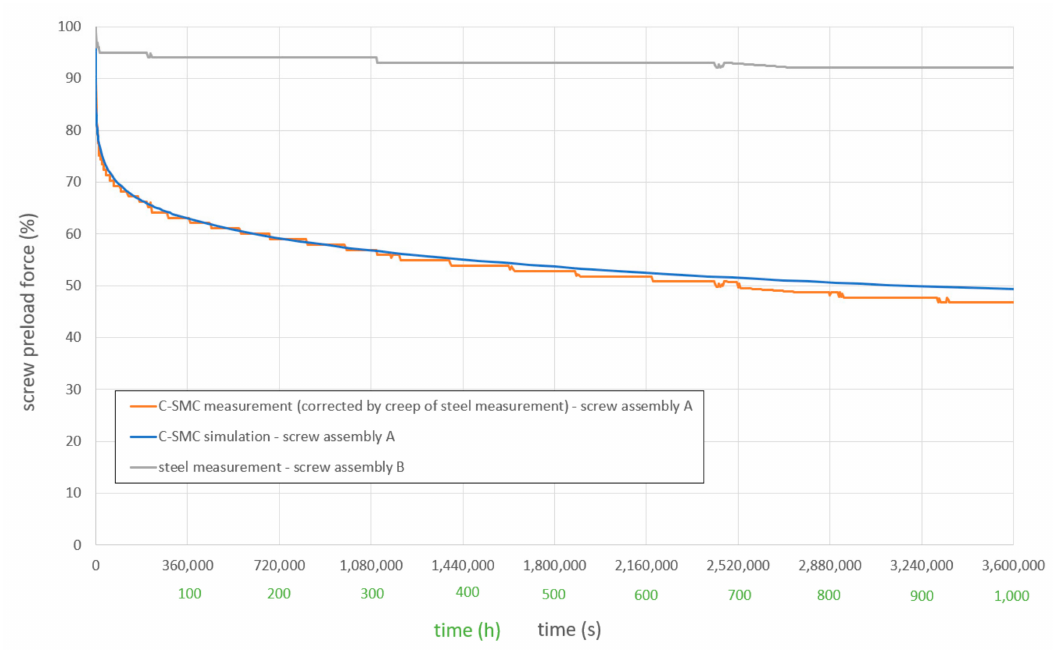
Figure 7. Loss of screw force over